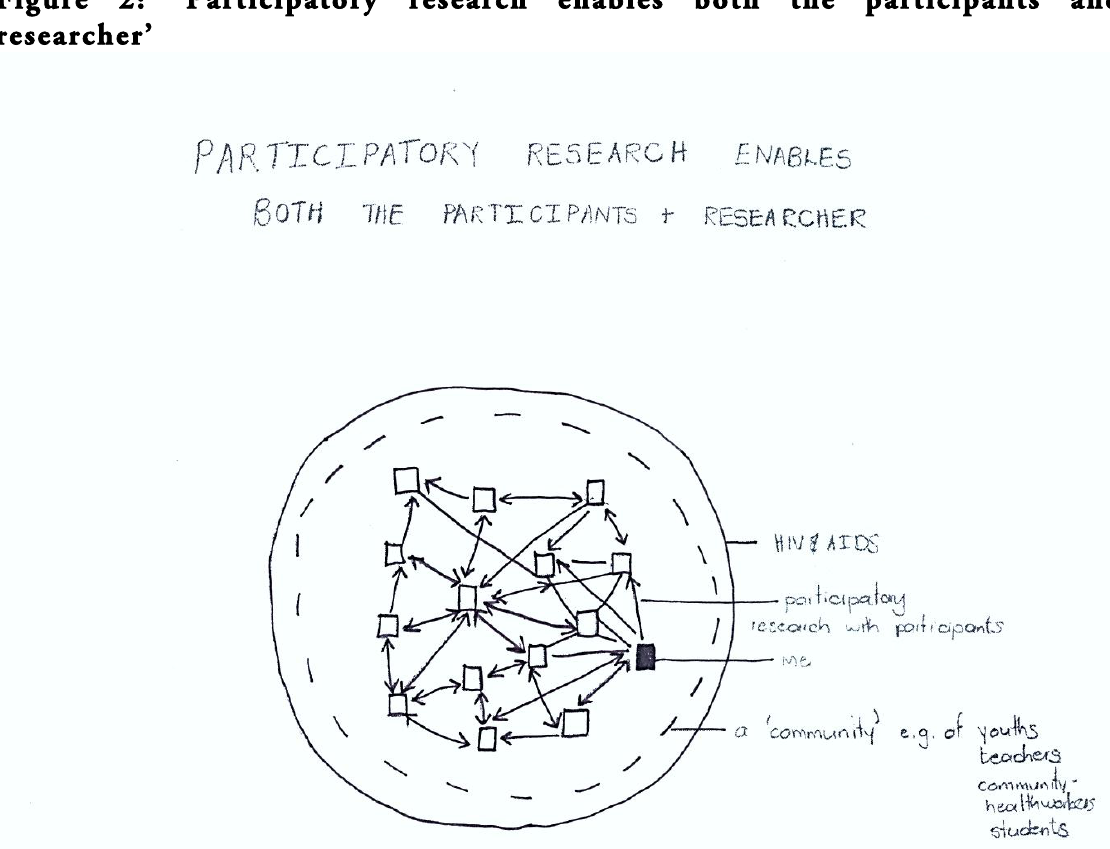
Figure 2: ‘Participatory research enables both the participants and